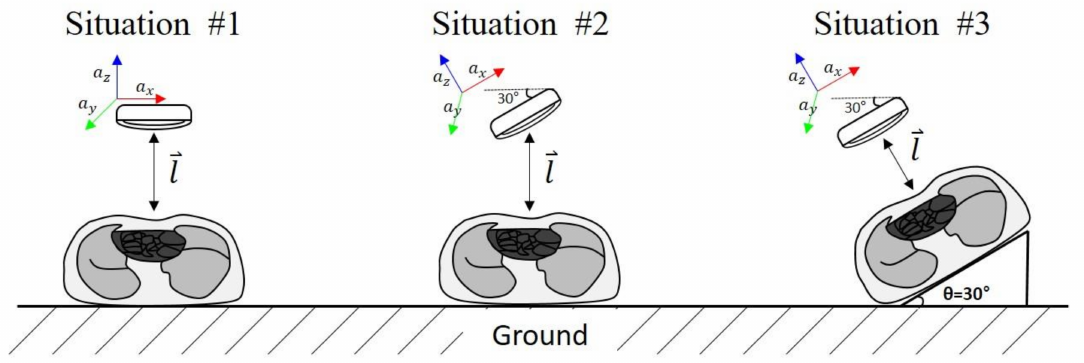
Figure 6. Geometric configurations for the